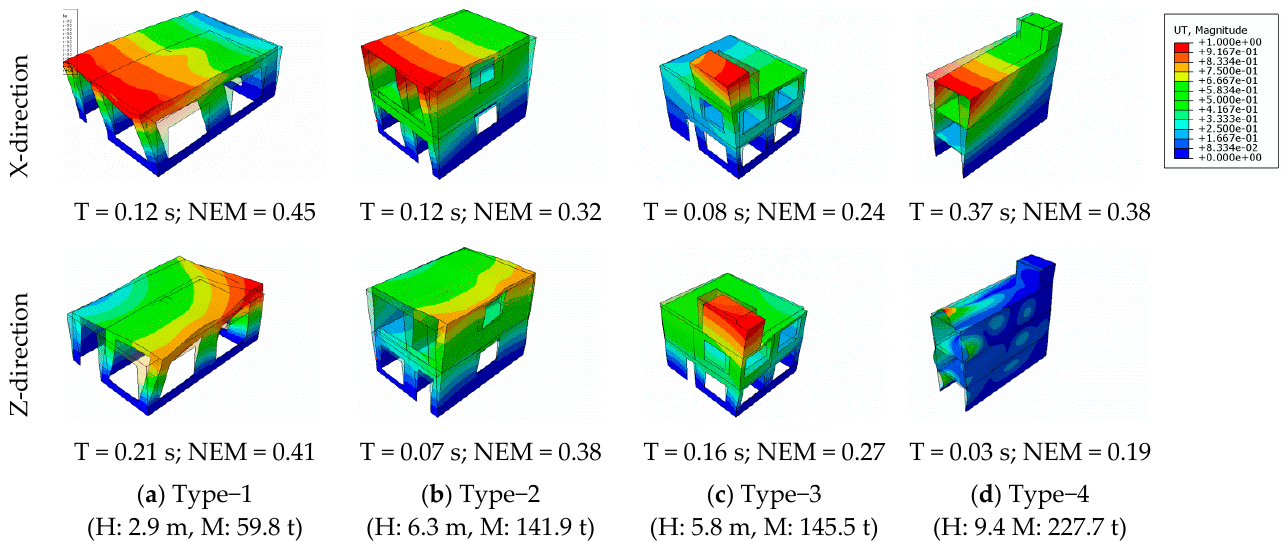
Figure 7. Natural period and mode shapes of the URM model buildings (H: total height; M: total mass).